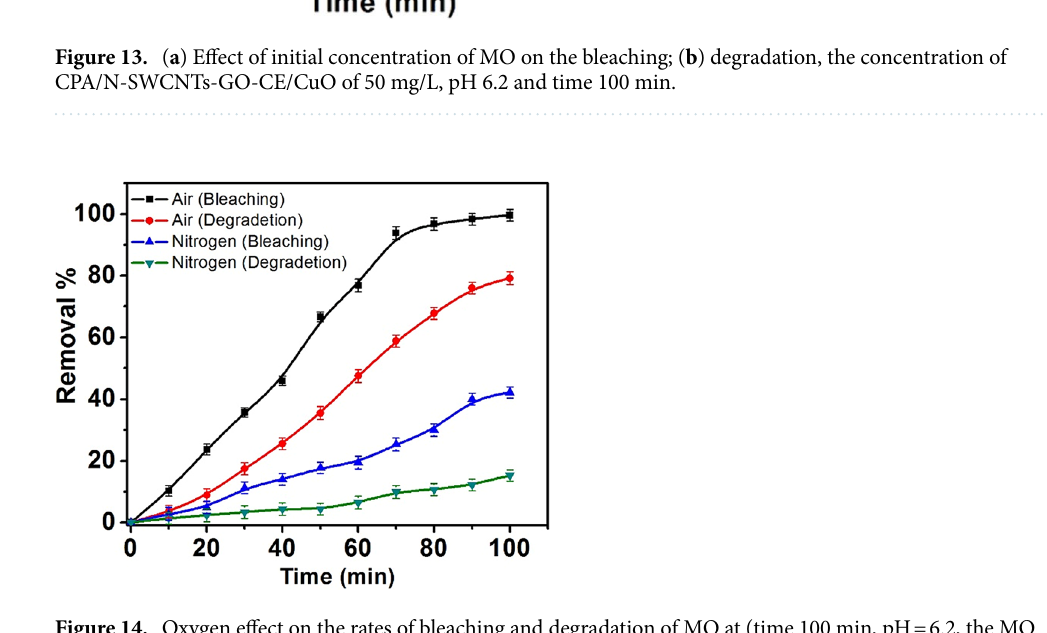
Figure 14. Oxygen effect on the rates of bleaching and degradation of MO at (time 100 min, pH = 6.2, the MO concentration of 10